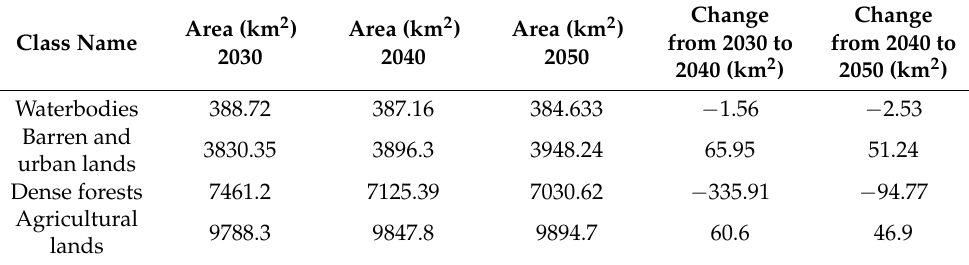
Table 6. Projected land use and land cover changes for the years 2030, 2040, 2050.